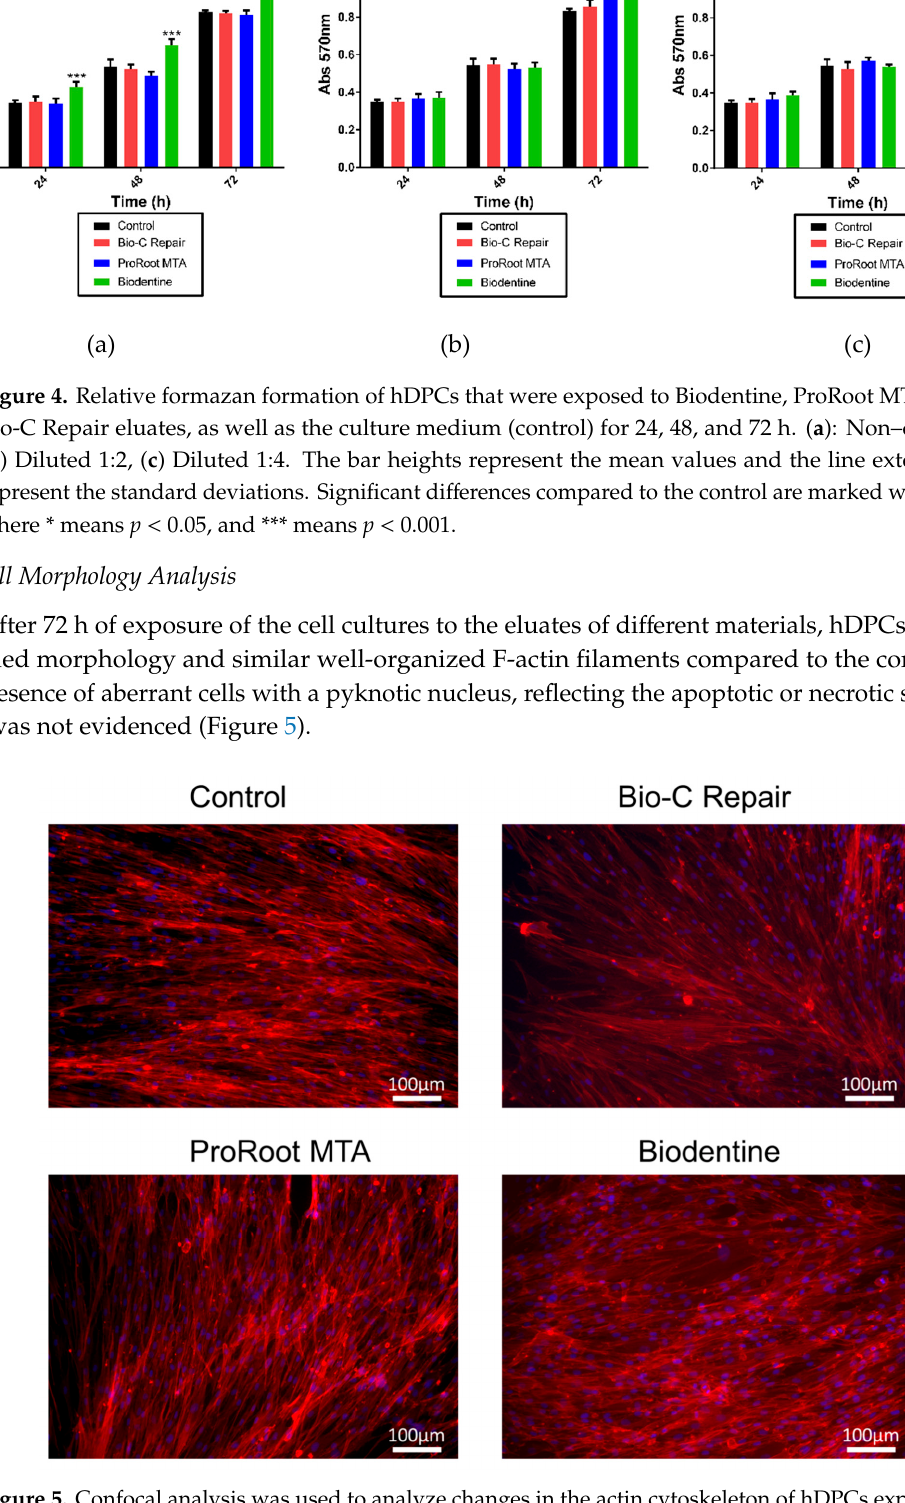
Figure 5. Confocal analysis was used to analyze changes in the actin cytoskeleton of hDPCs exposed to material eluates. The confocal microscopy images show F-actin labeling with CruzFluor 594-conjugated phalloidin (red) and nuclei with DAPI (blue). Scale bar: 100 µ